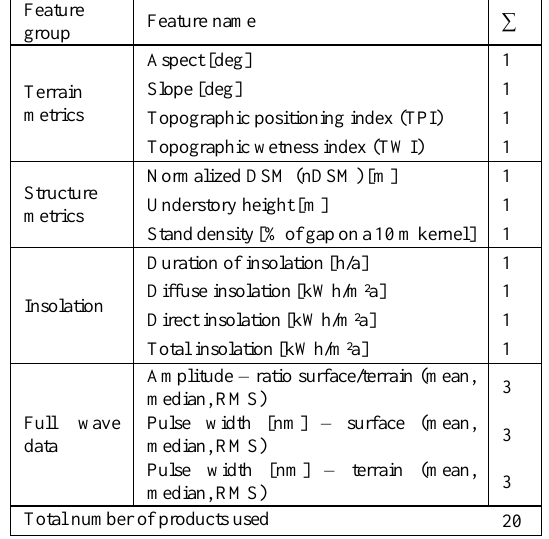
Table 2. Metrics derived from ALS data used as predictor variables, exported as 1 m resolution raster data.  represents the number of data products.